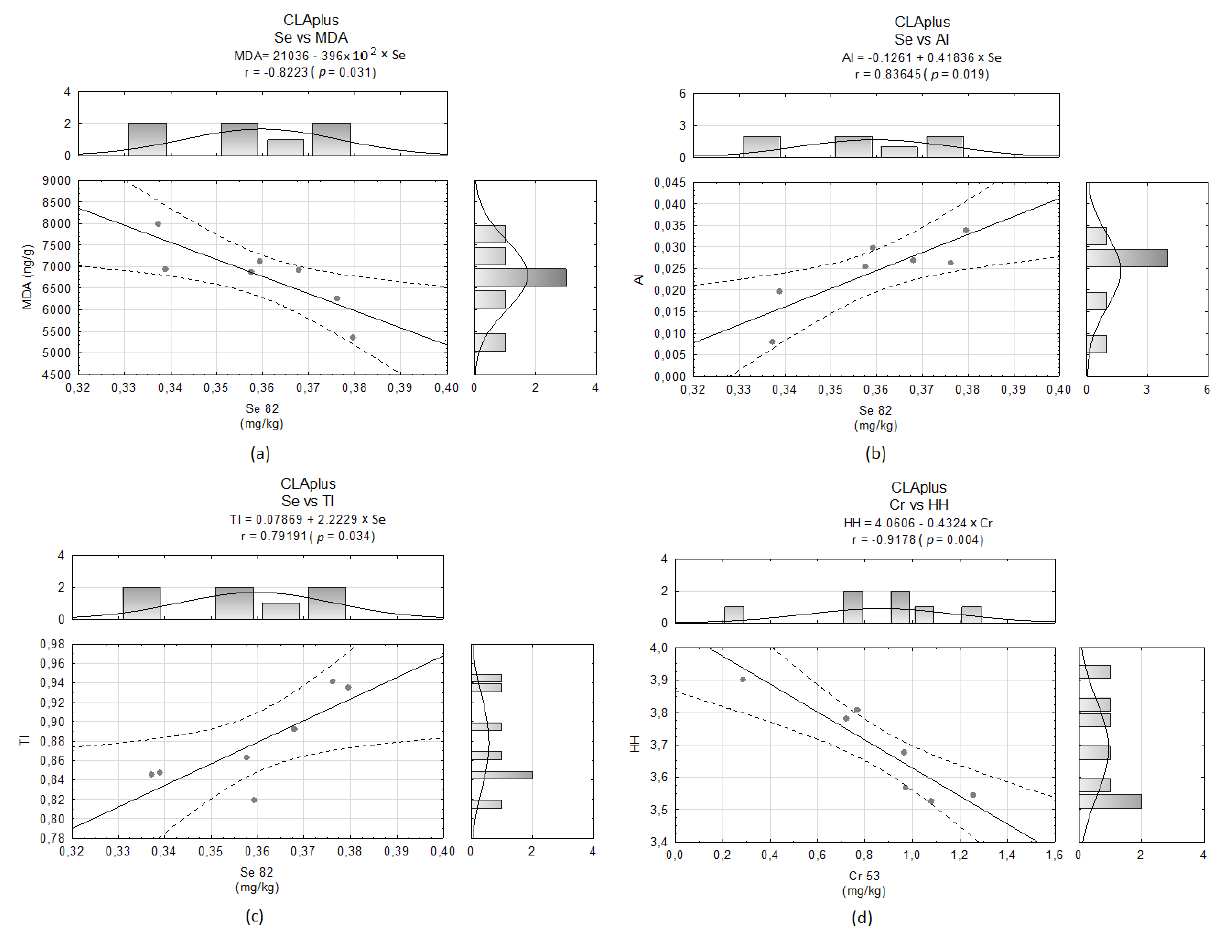
Figure 7. Correlations between ( a ) Se and malondialdehyde (MDA) content, ( b ) Se and AI, ( c ) Se and TI and ( d ) Cr and HH index in the CLAplus group.